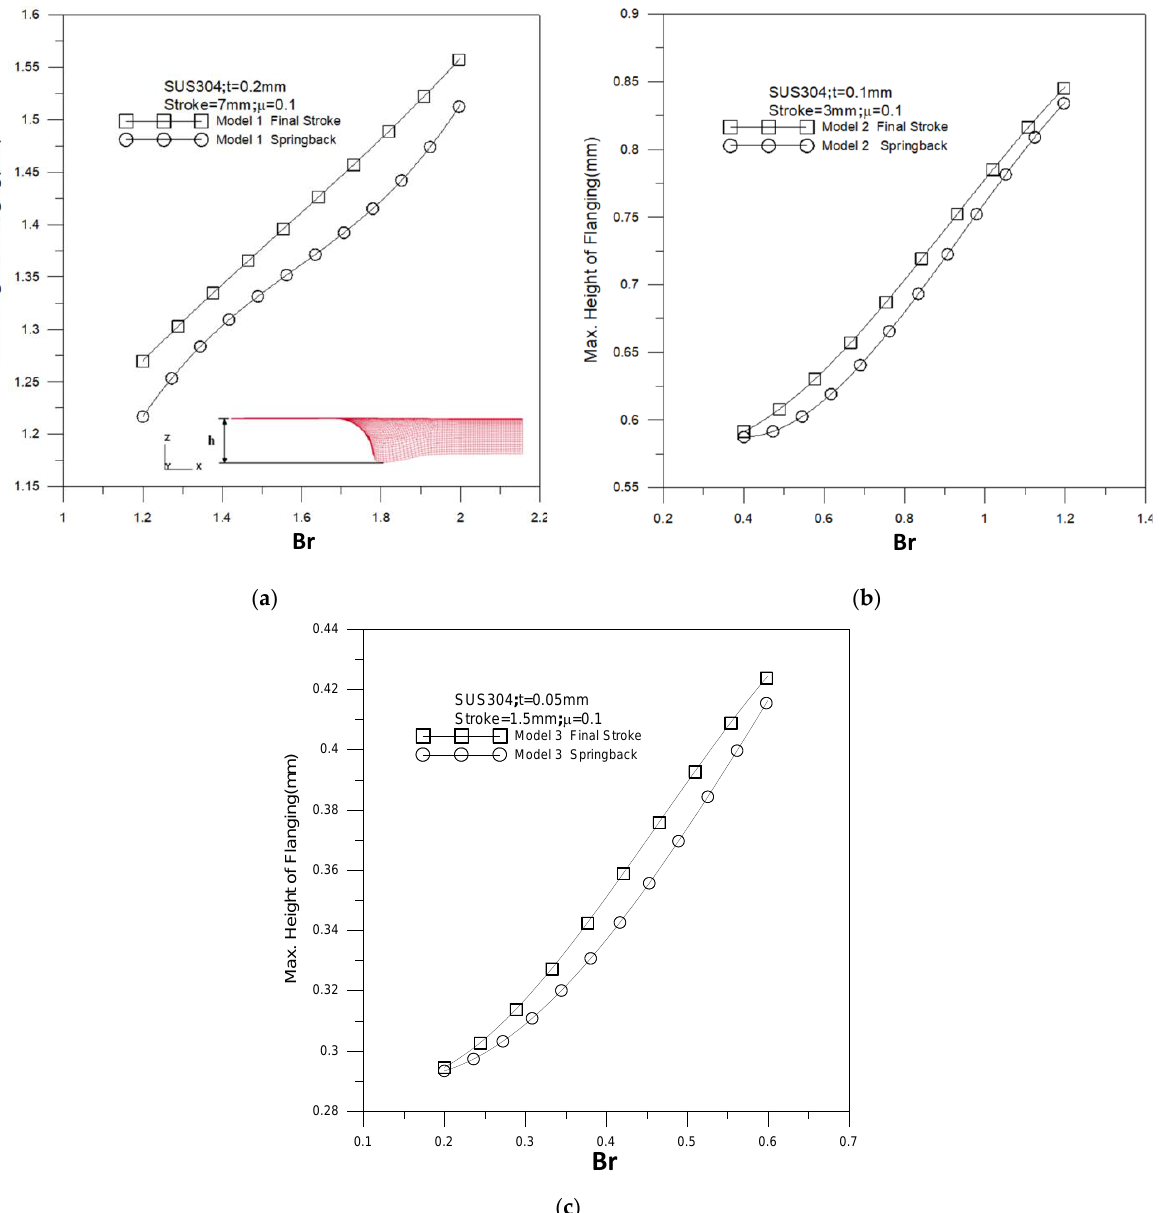
Figure 9. The r elationship between the fillet radius and the height of flange: ( a ) Model 1; ( b ) Model 2; ( c ) Model 3. 4.2. The Impact of the Punch Fillet Radius on the Process In this section, the results of changes to the fillet radius (Rp) of the punch are inves- tigated and analyzed to determine their effect after the final stroke and spring-back. The radius of the punch fillet and relative parameters are shown in Table 7. The material pa- rameters have been corrected by a scale factor and the material has been regarded as iso- tropic.